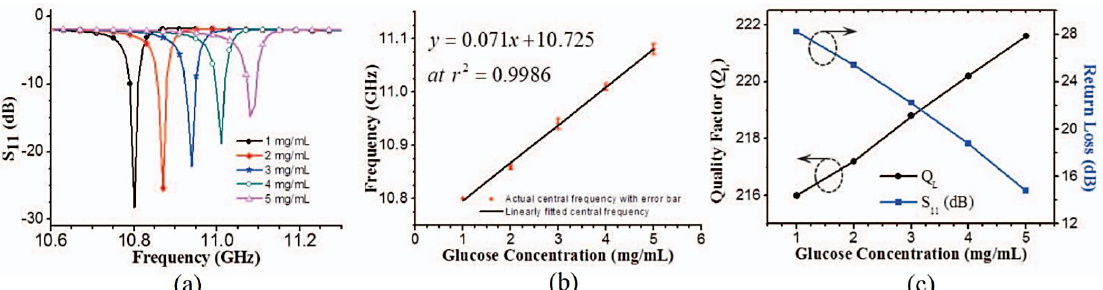
Figure 26. Detection of glucose level using measured S-parameters: ( a ) shift of central frequency; ( b ) linearly fitted central frequency and actual central frequency with error bar; and ( c ) variation of loaded quality factor ( Q L ) and return loss ( S 11 ) with variation in glucose concentration [94].